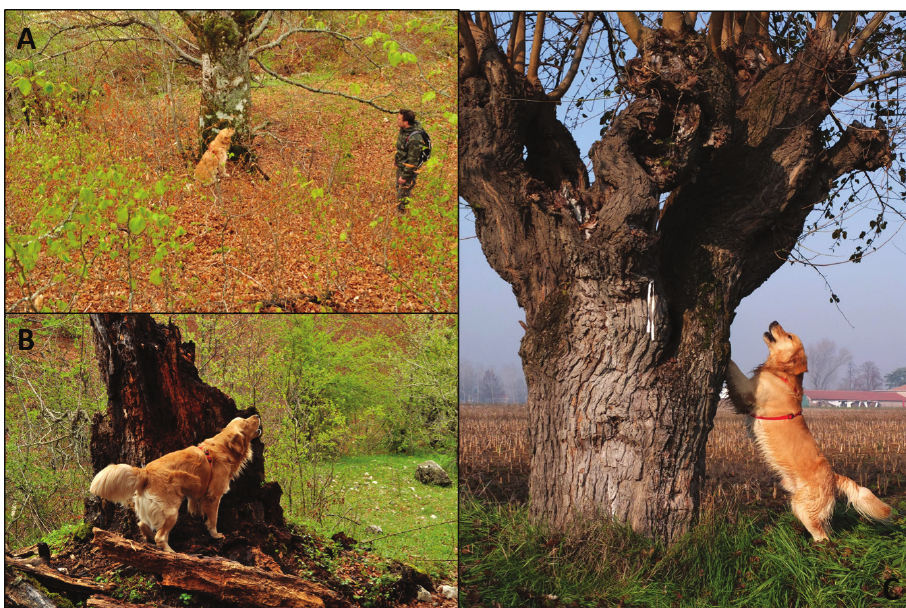
Figure 5. Teseo signalling the target to the handler: A sitting beside a tree containing the target, barking and looking at scent source and handler B pointing the target, barking and looking at the handler C scratching the trunk and barking (Photos A and B by Emilia Capogna, photo C by S ӧ nke